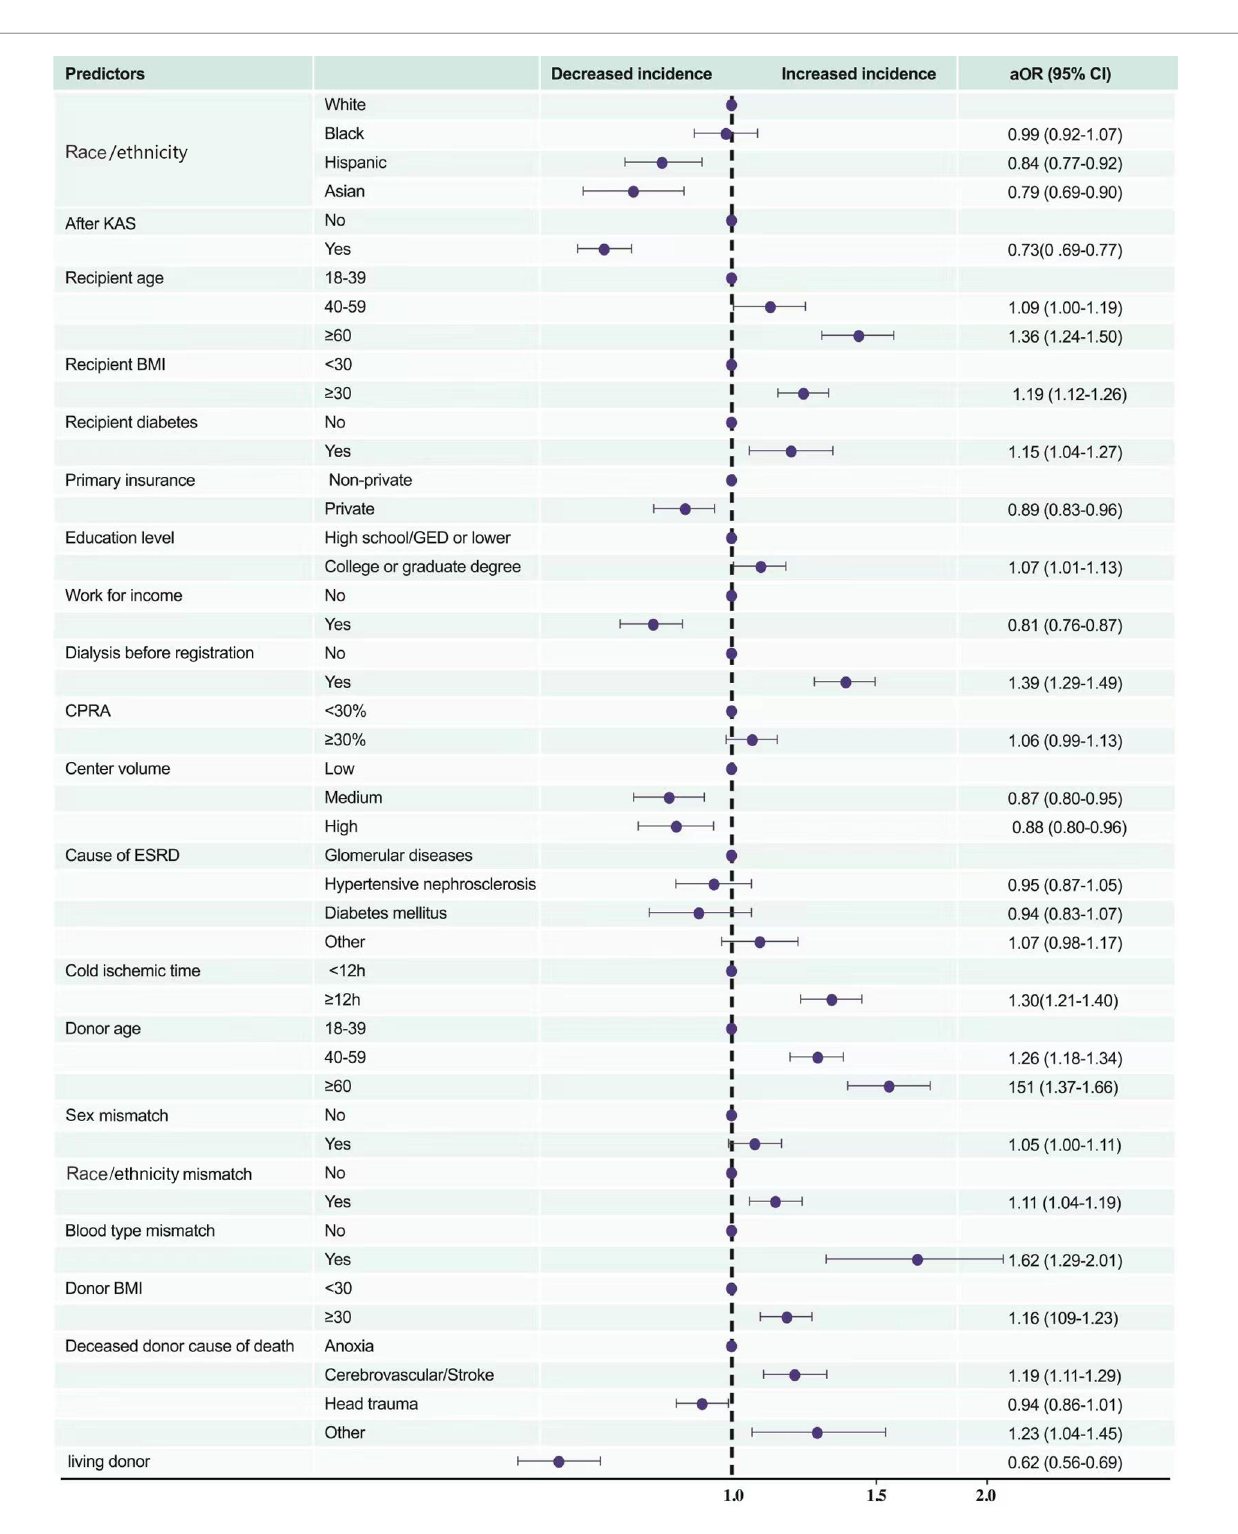
FIGURE 6 Multivariate predictors of posttransplant in-hospital death or PNF. KAS, Kidney Allocation System BMI, body mass index (calculated as weight in kilograms divided by height in metres squared); CPRA, calculated panel reactive antibody; ESRD, end-stage renal disease; DM, diabetes mellitus; PNF, primary